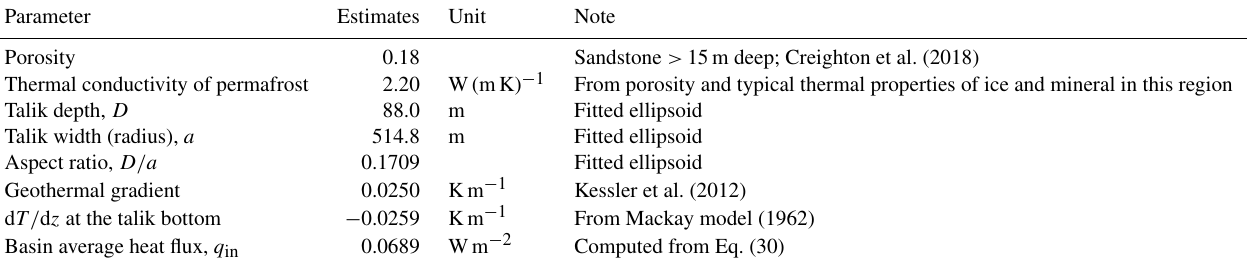
Table 1. Computed incoming heat flux with the estimated parameters.